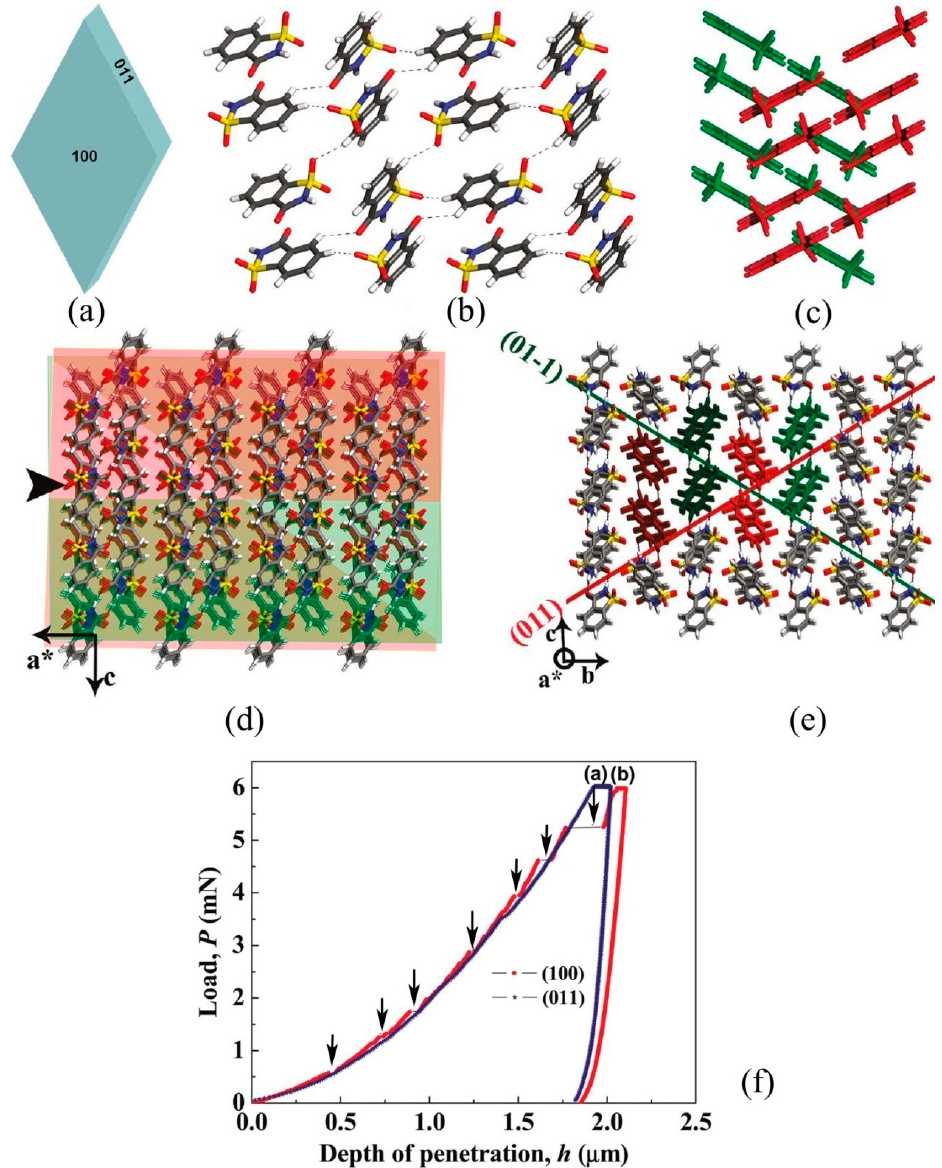
Figure 6. ( a – e ) Saccharin crystal with index faces, top view of intermolecular interactions in the (011) plane, oblique angle arrangement of molecules concerning the (100) plane, view of molecular arrangement along (001) plane, and the stacking of molecules in the [100] direction, respectively. The indentation direction (a*) is represented by the arrowhead. ( f ) Representative P-h curves obtained from the (100) and (011) planes. Arrows indicate pop-ins. (Reprinted with permission from the American Chemical Society, Reference 85).